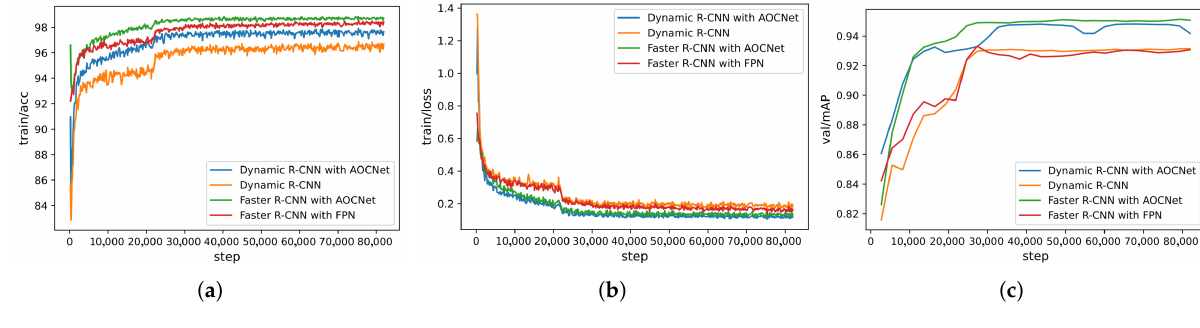
Figure 15. The results on our dataset. ( a ) Accuracy. ( b ) Loss. ( c ) mAP.